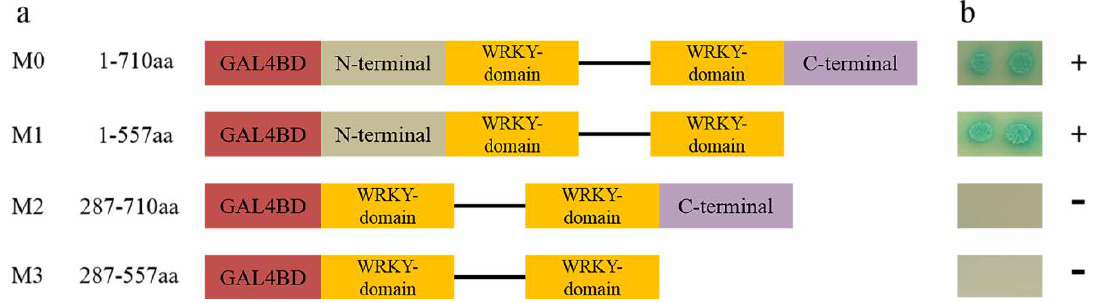
Figure 6. Diagram illustrating the region of IbWRKY2 involved in self-transcriptional activation activity and assay. ( a ) Schematic diagrams represent the IbWRKY2 fragments encoding di ff erent parts of IbWRKY2 that were cloned into the pGBKT7 vector. M1 is a C-terminal deletion mutant, M2 is an N-terminal deletion mutant, and M3 has both the C- and N-terminal regions deleted. The numbers denote IbWRKY2 amino acid positions. ( b ) Transactivation assay of IbWRKY2 and its deletion mutants. The transactivation activity is shown on the right (plus sign is positive and minus sign is